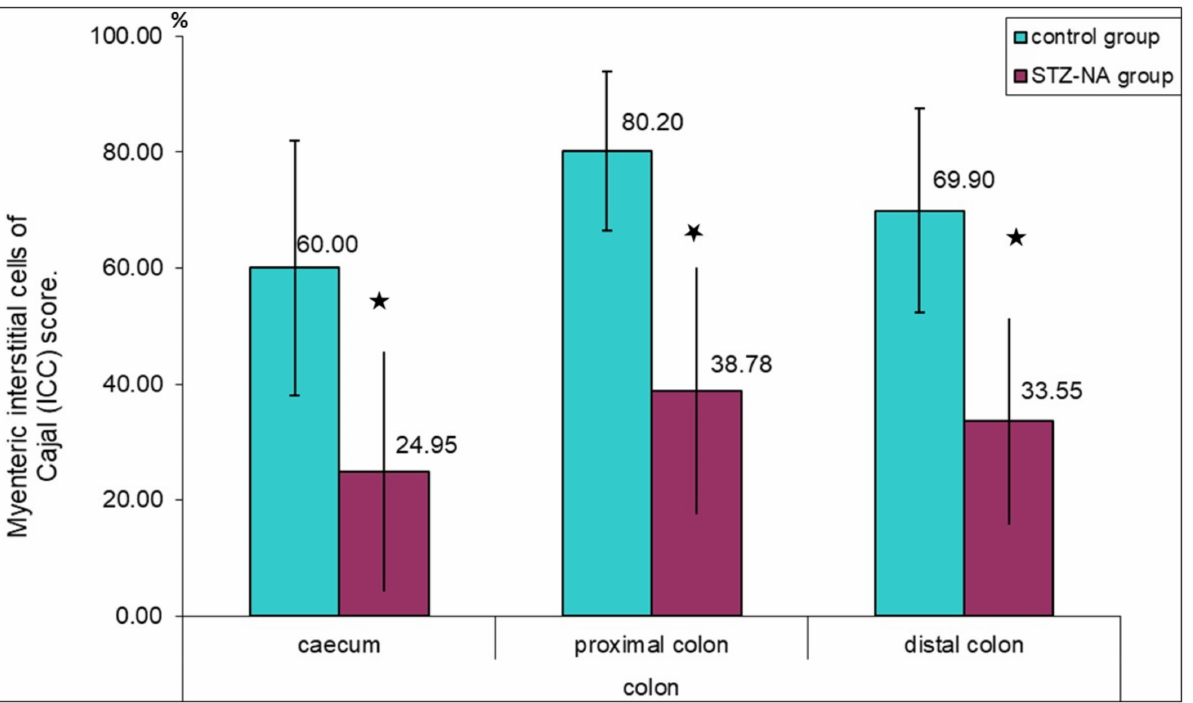
Figure 4. Myenteric interstitial cells of Cajal (ICC-MP) score in the muscle layer of the rat colon in control and STZ–NA group. Numerical values presented in the figure correspond to the mean values of the ICC-MP score, (cid:70) statistical significance ( p ≤